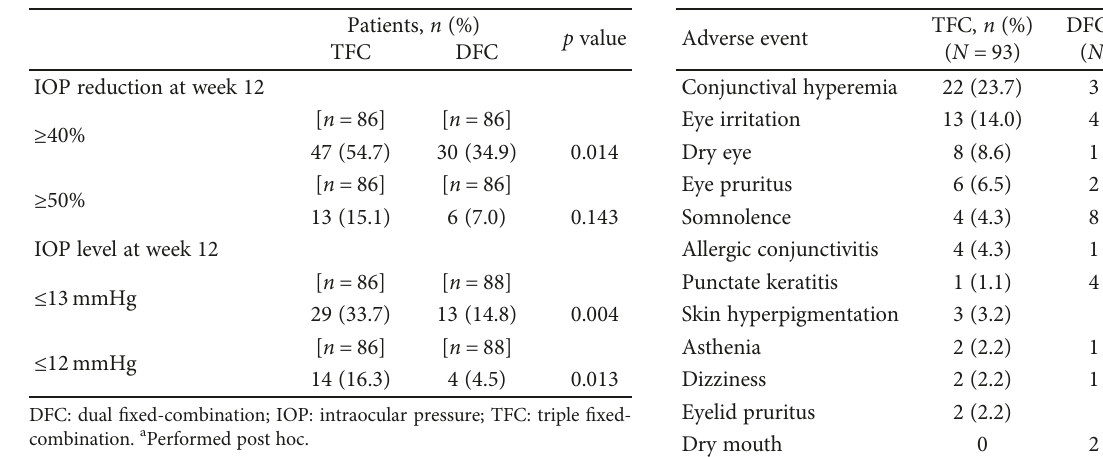
Table 4: Treatment-related adverse events reported in two or more patients in one treatment